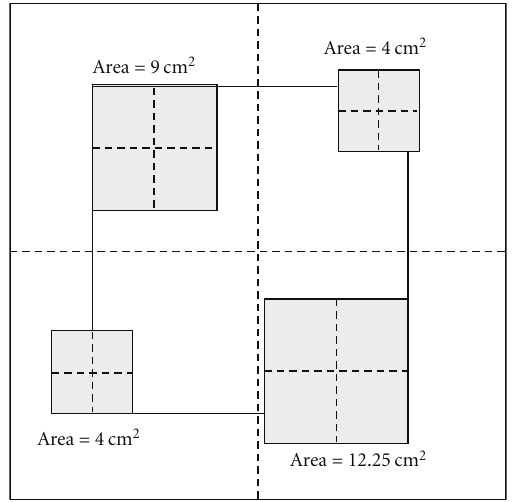
Figure 6: The hypothetical example screen showing inputs required to compute the sequence